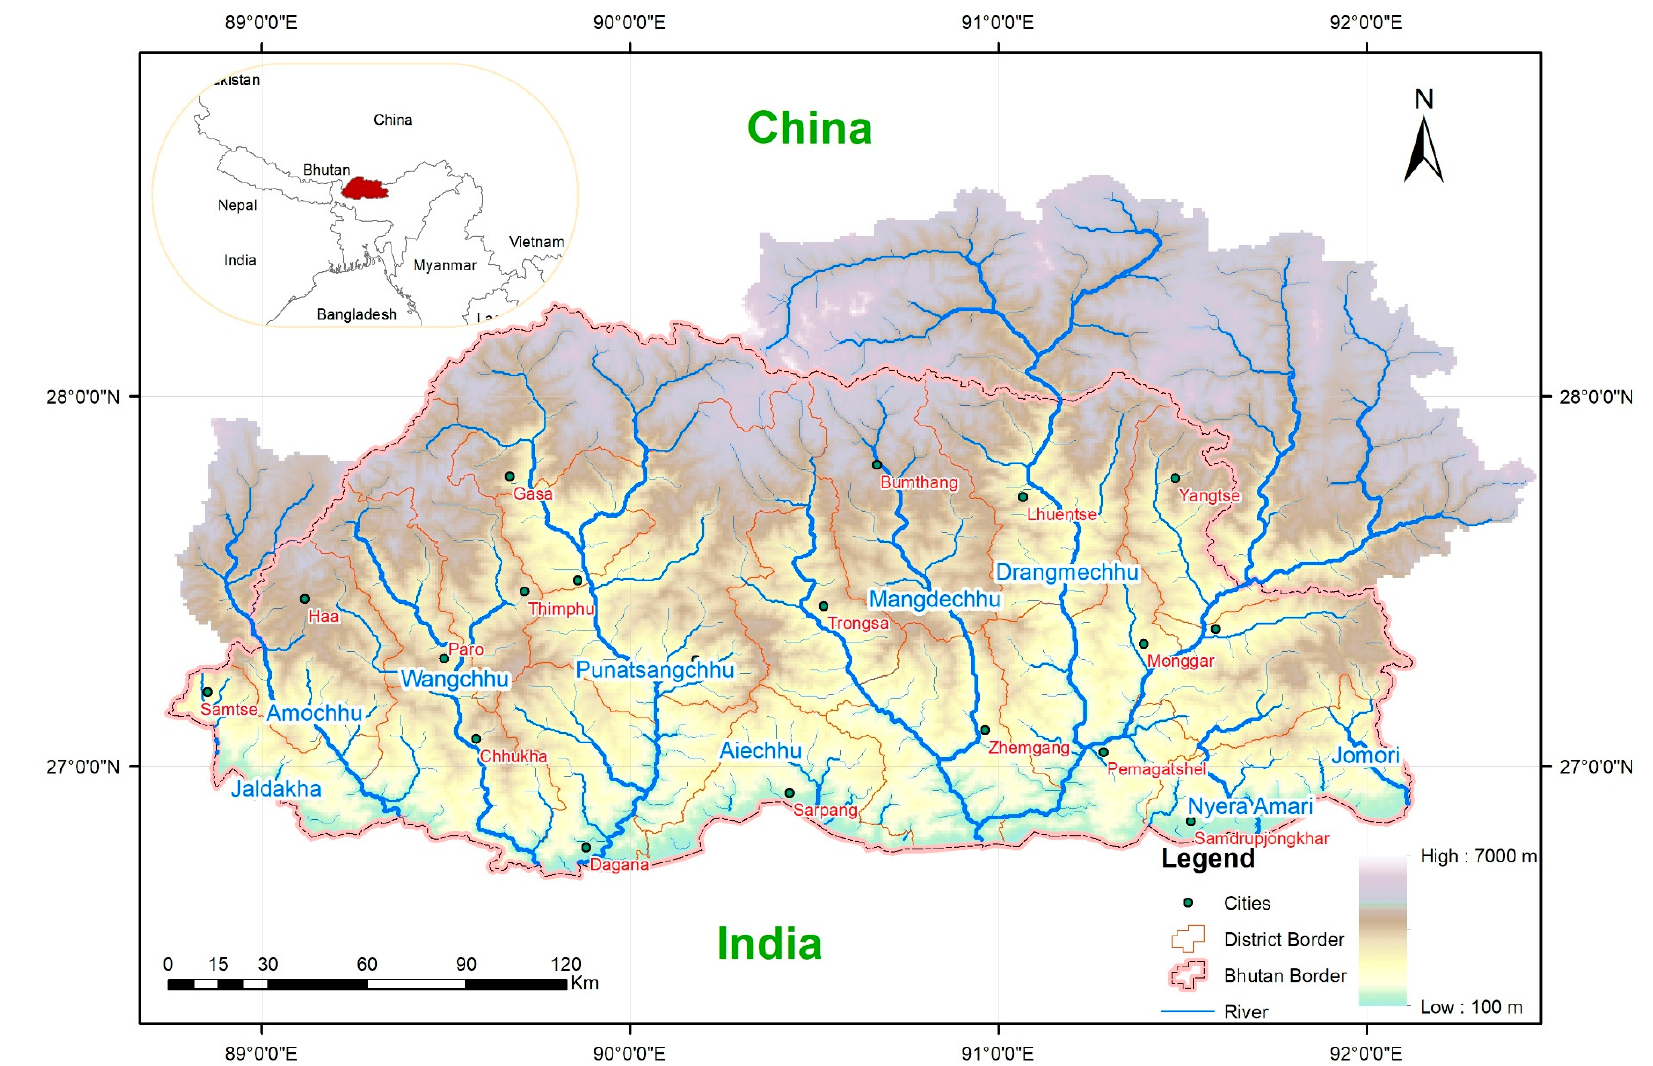
Figure 1. Map of Bhutan along with its geographical location and hydrological features (map developed from data of HydroShed [40]).